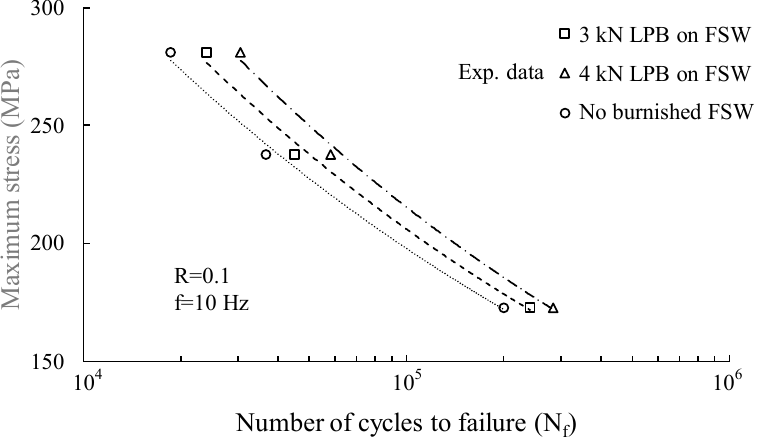
Figure 12. S–N curves of LPBed joints and their comparison with that of friction stir processed sam- ples.